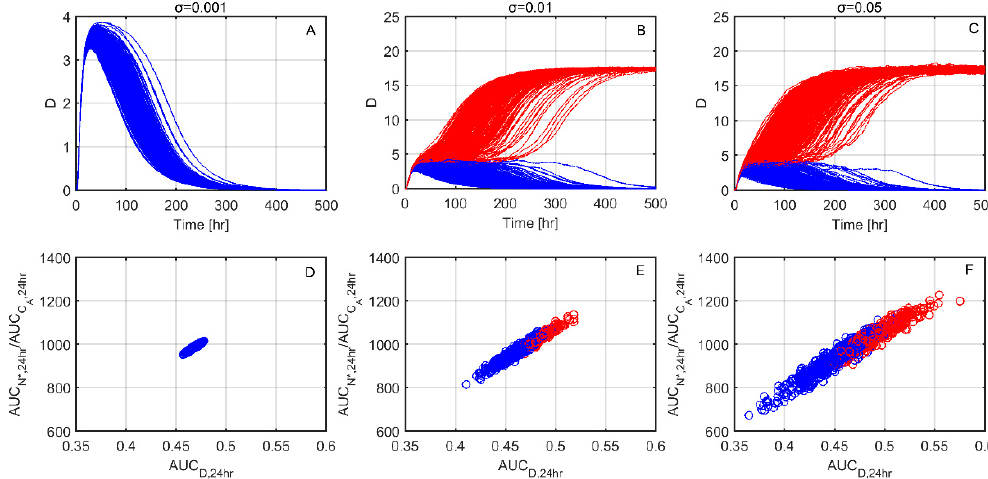
Figure 3. Healthy vs. aseptic death dynamics for increasing noise levels ( σ ). ( A – C ) Tissue damage ( D ) time responses for increasing noise levels ( σ ). Blue lines indicate responses that reach the healthy steady state whereas red lines indicate responses that reach the aseptic death state. ( D – F ) 24 h AUC of phagocytes ( N* ) over 24 h AUC of anti-inflammatory mediators ( C A ) with respect to the 24 h AUC of tissue damage ( D ) (AUC D ). In accordance with the upper panel blue circles indicate resolving profiles and red circles non-resolving.